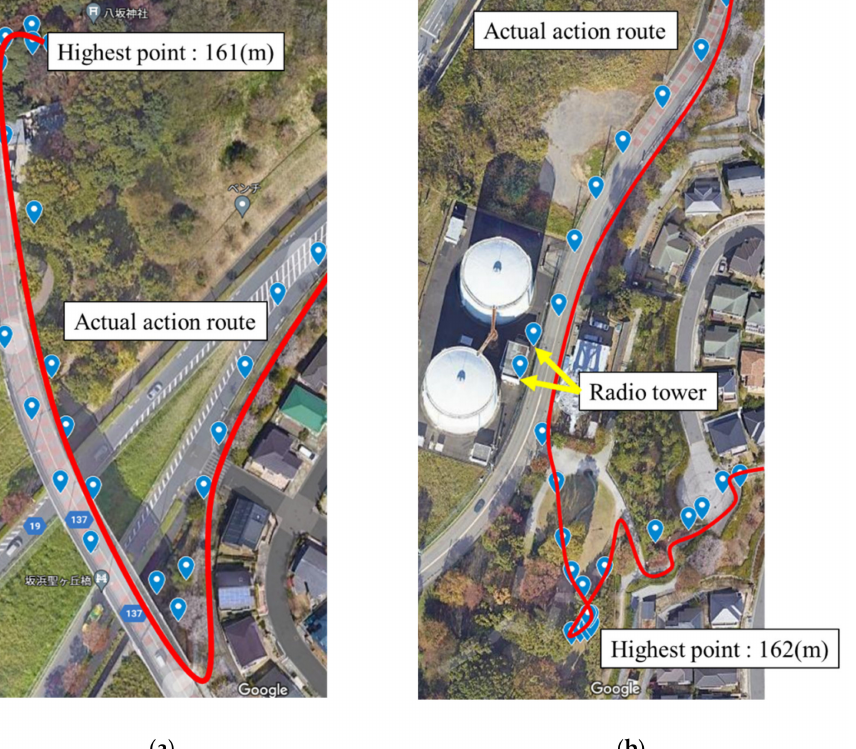
Figure 7. GPS location and its error in each area. ( a ) GPS location in a relatively high-altitude area with good visibility (Yasaka Shrine, Tama City, Tokyo: 161 m above sea level). ( b ) GPS position information and its error near a wireless base station tower (Inagi, Tokyo, Japan, at an elevation of 162